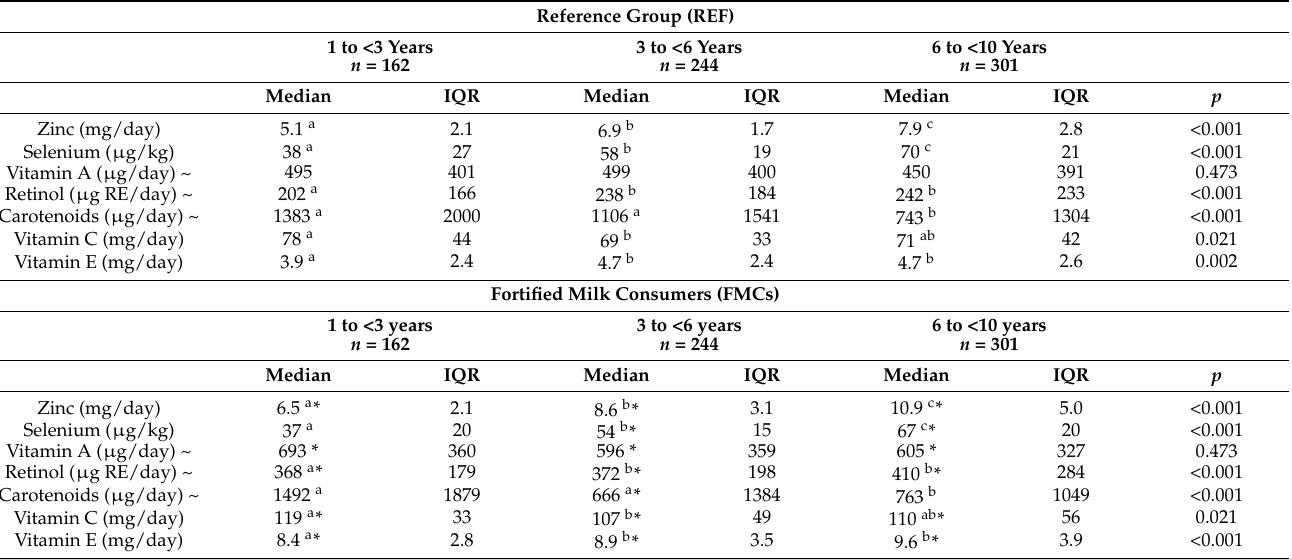
Table 2. Total antioxidant minerals and vitamins intakes by age and subpopulations ( n =